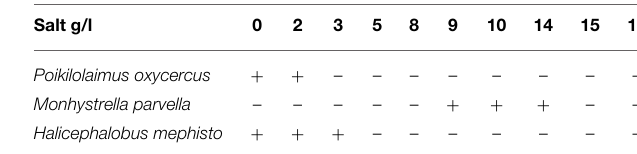
TABLE 3 | Salt requirement